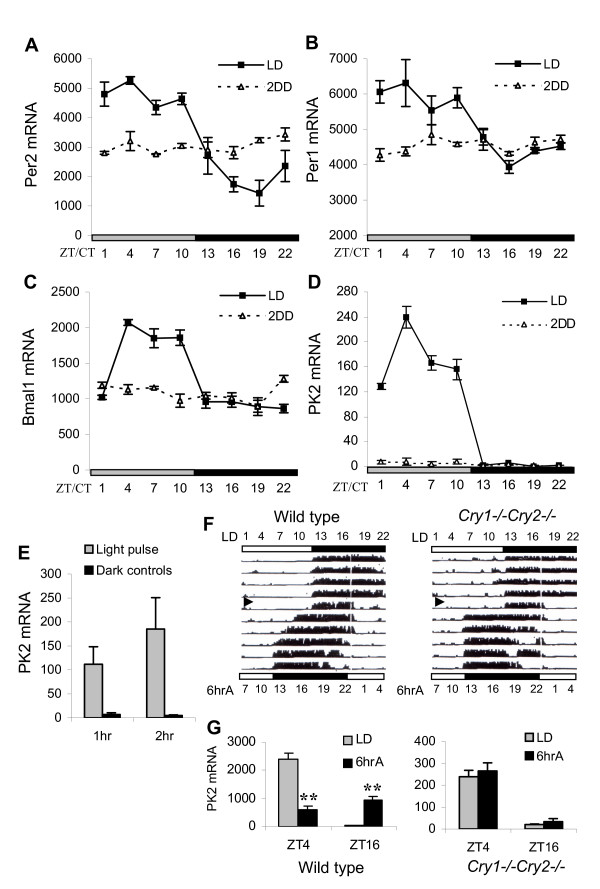
Light-driven molecular rhythms in the SCN of Cry1-/-Cry2-/- mice. Temporal mRNA profiles of Per2 (A), Per1 (B), Bmal1 (C) and PK2 (D) in Cry1-/-Cry2-/- mice under 12L:12D (LD) or two days constant darkness (2DD). Each value represents the mean ± SEM of 3–4 animals. Two-way ANOVA with Bonferroni's posthoc analysis was used to test for significant interactions between expression across time of sampling and under different lighting conditions (LD vs 2DD). p < 0.0001 (Per2), p < 0.002 (Per1), p < 0.0001 (Bmal1) and p < 0.0001 (PK2). (E) Light pulse-induced PK2 mRNA in Cry1-/-Cry2-/- mice. PK2 mRNA was measured one and two hours after brief light pulse at ZT14 (shaded bar). Black bar represents dark controls that did not receive light pulse. Each value represents the mean ± SEM of 5–6 animals. Two-way ANOVA indicates a significant difference in PK2 expression between light and dark treatment (p < 0.05), however, the PK2 induction is not significantly different between the two timepoints (1 hr vs 2 hr). (F) Locomotor behavioural rhythms of wild type (left) and Cry1-/-Cry2-/- mice (right) in response to 6 hour advance of light/dark cycle. Open and filled bars indicate light and dark periods, respectively. Black arrow indicates the day of 6 hour advance shift (6hrA). Numbers above and below the actograms represent timescale in zeitgeber time (ZT) for LD and 6hrA. (G) Rapid adjustment of PK2 rhythm in Cry1-/-Cry2-/- mice to 6 hour advance (6hrA). PK2 mRNA was quantitated in the SCN of wildtype and Cry1-/-Cry2-/- mice under LD (shaded) or 6hrA (black). Each value represents the mean ± SEM of 3–4 animals. Three-way ANOVA with Bonferroni's post hoc analysis indicates a significant interaction between light/dark cycle (LD vs 6hrA), timepoint (ZT4 vs ZT16) and genotype (wildtype vs Cry1-/-Cry2-/- mice), p < 0.001. Two-way ANOVA with Bonferroni's post hoc analysis show that there is significant difference in wildtype PK2 expression level between LD and 6hrA, (ZT4, ***p < 0.001; ZT16, **p < 0.01), but not in Cry1-/-Cry2-/- mice (ZT4, p = 1.000; ZT16, p = 1.000).